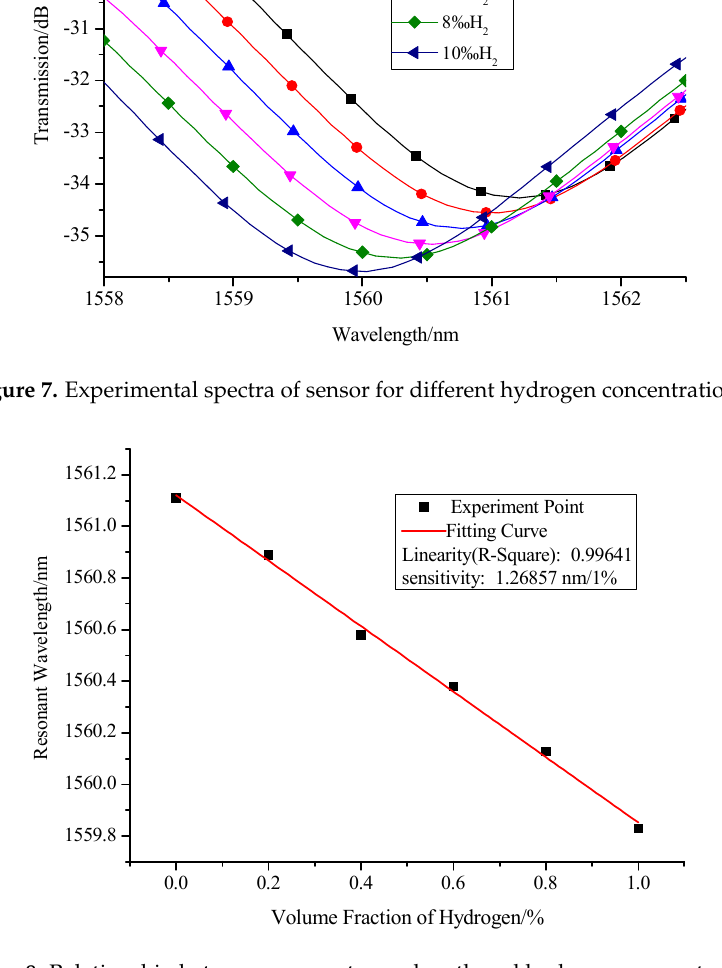
Figure 8. Relationship between resonant wavelength and hydrogen concentration.